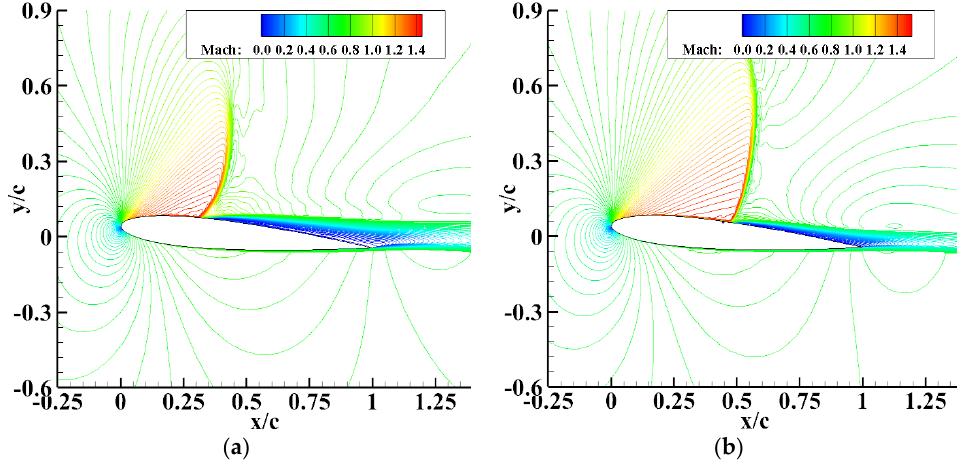
Figure 8. Comparison of unsteady numerical results ( a ) without tangential blowing and ( b ) with tangential slot blowing.